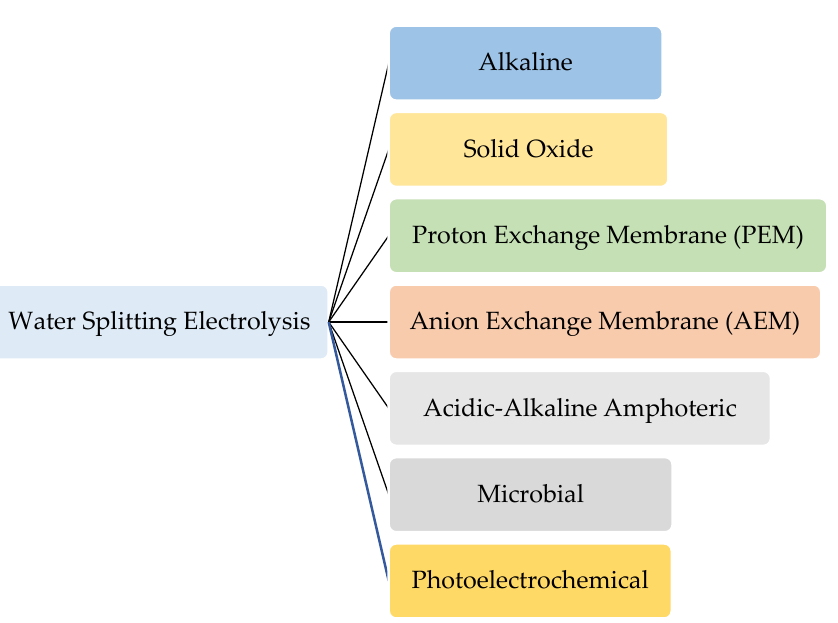
Figure 1. Water splitting electrolysis technologies for hydrogen production .